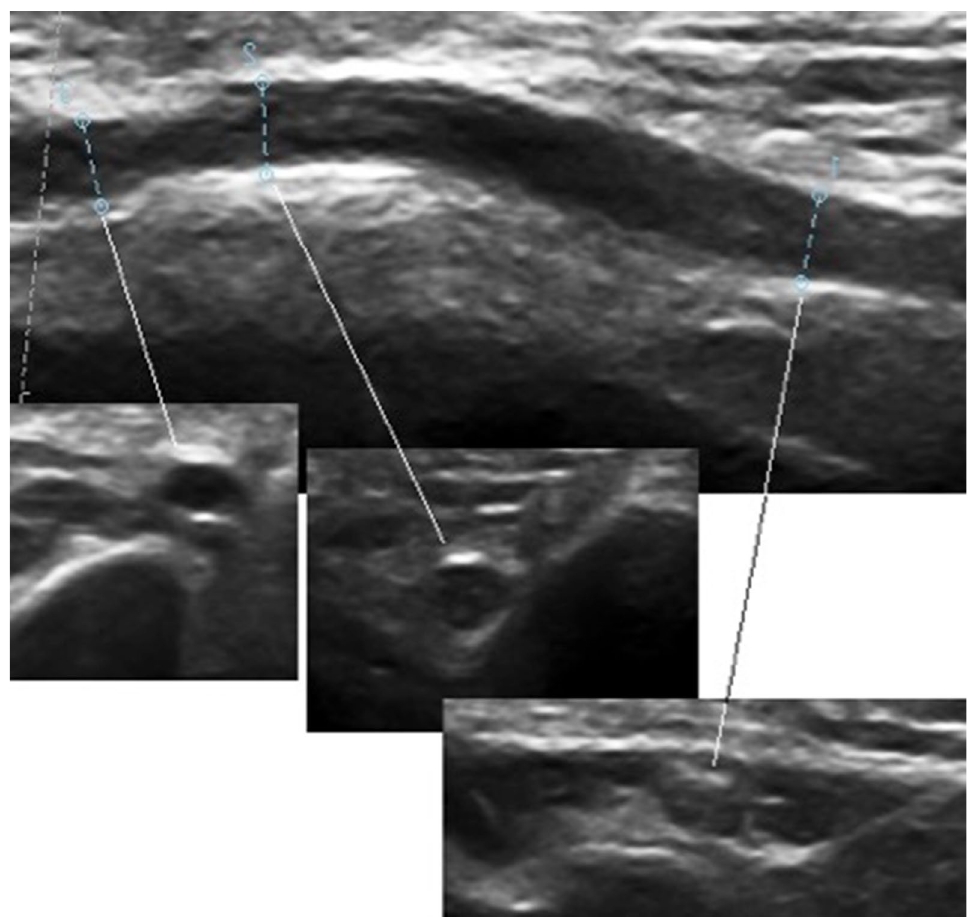
Fig. 2 Above, horizontal elbow position. Ultrasonographic evalution of ulnar groove. Left proximal segment, right distal segment Below, transversal evaluations. Right, distal segment (ulnar tunnel); middle and left proximal segment (ulnar